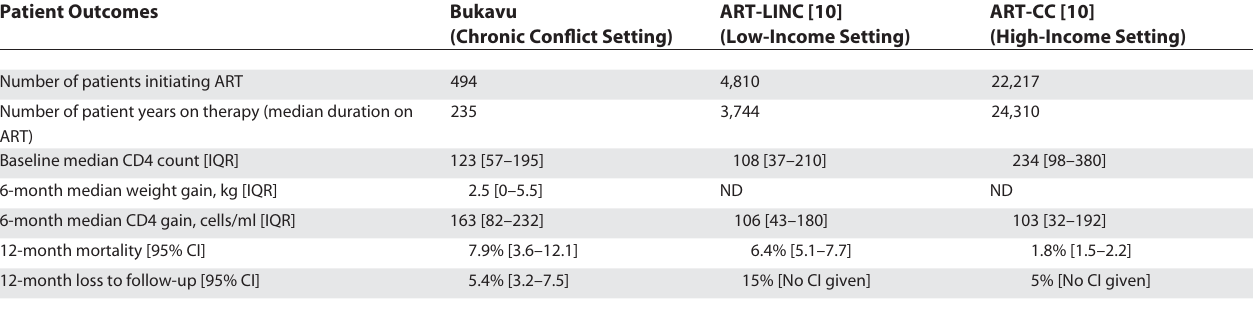
Table 2. Comparison of ART Patient Outcomes from Programmes in Chronic Confl ict Settings with Non-Confl ict Settings in